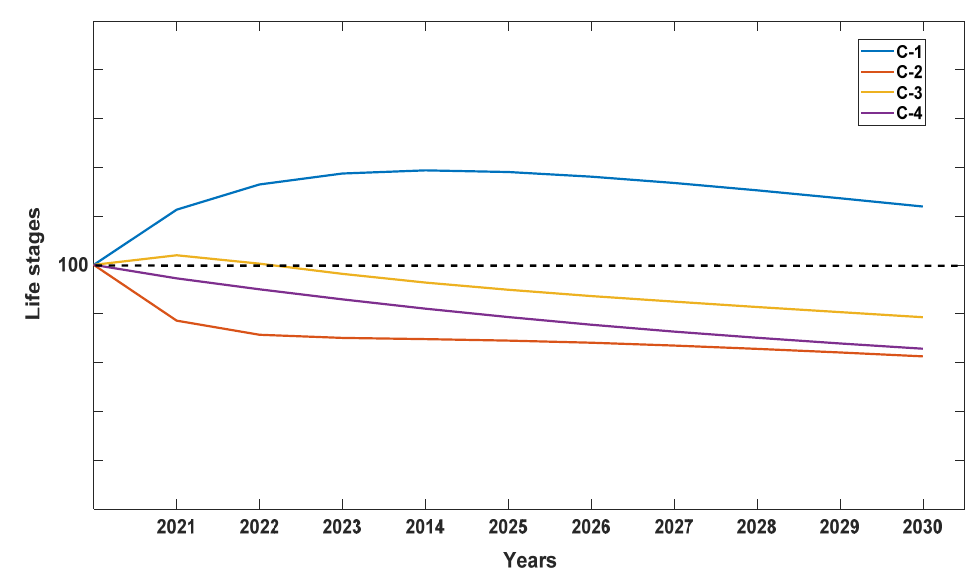
Figure 8. Projection of the behavior between the different orchid life stages (seedlings, juveniles, mature) for the next 10 years for all seven populations in the Florida Panther National Wildlife Refuge. Orchid life stages listed include seedlings (C-1), juveniles (C-2), smaller mature (C-3), and larger mature orchids (C-4). This graph shows that the number of mature plants (C-3, C-4) will decrease.